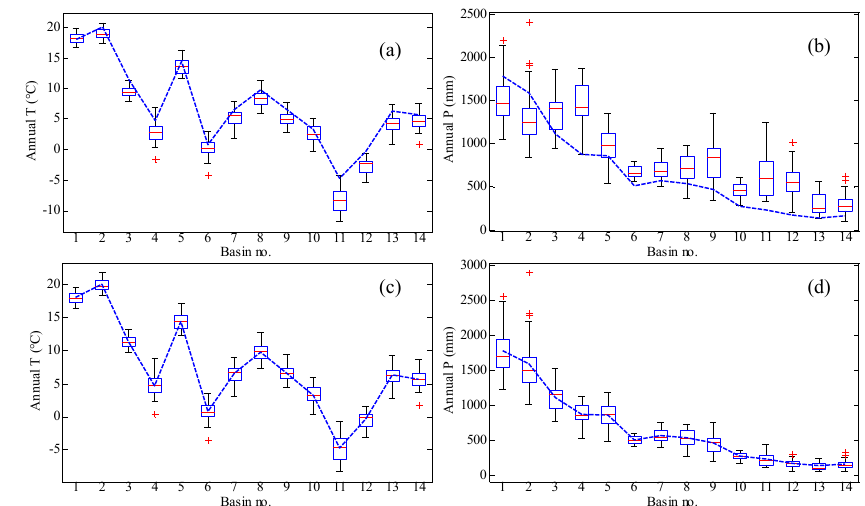
Figure 2. Box plots of the simulation results of (a) mean annual T and (b) mean annual P and the bias correction results of (c) mean annual T and (d) mean annual P from 28 GCMs for the period 1971–2000 in the 14 river basins. The boxes denote the interquartile model spread (range between the 25th and 75th quantiles), with the horizontal line indicating the ensemble median and the whiskers showing the extreme range of the 28 CMIP5 model simulations. The blue dotted lines denote the observed results of mean annual T and mean annual P for the period 1971–2000. The basin number is consistent with that given in Fig. 1.